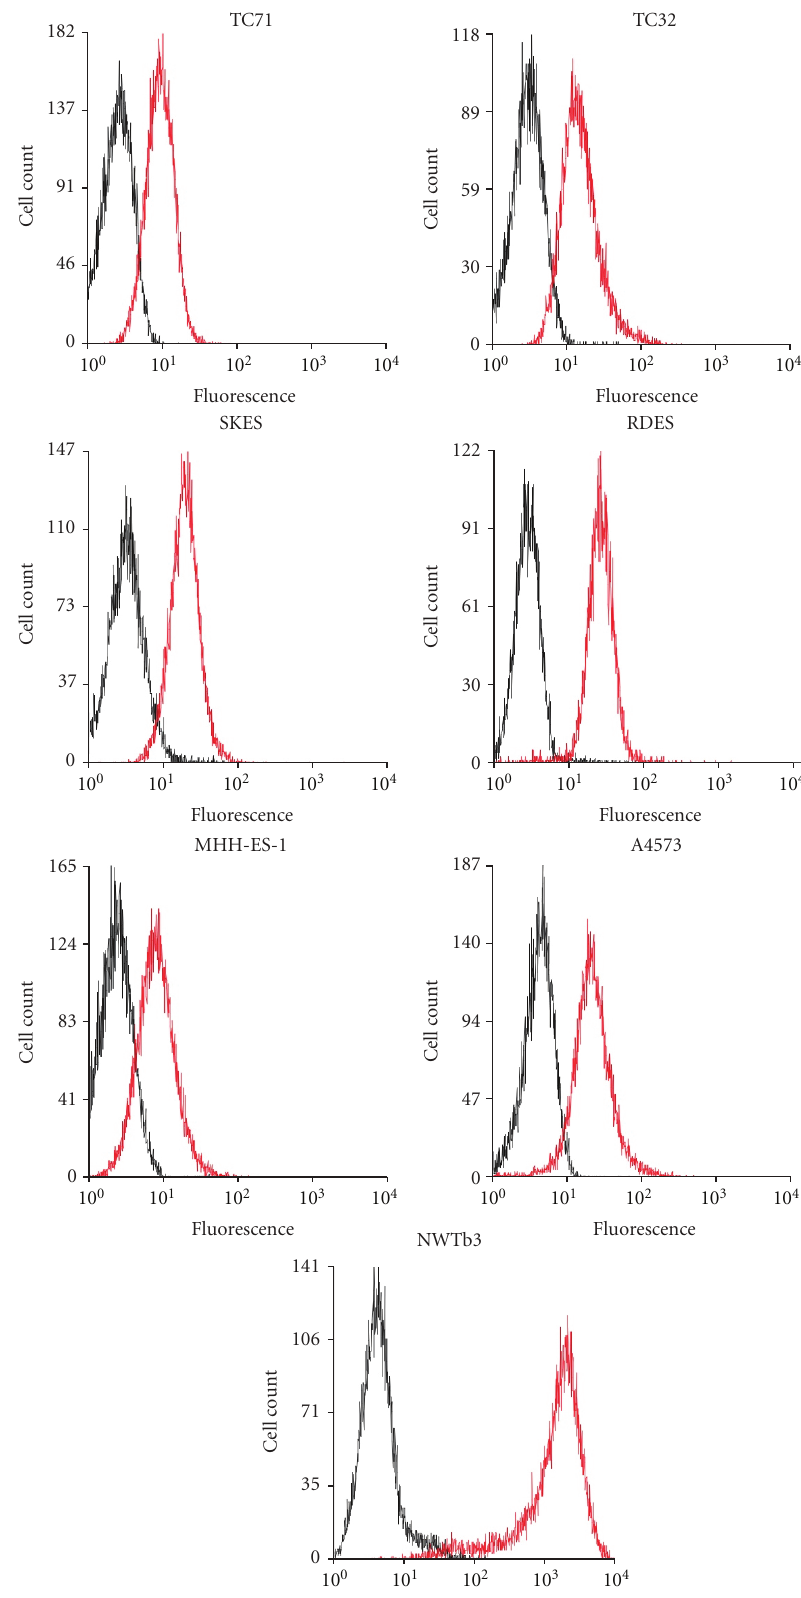
F 2: Flow cytometric analysis of IGF-1R-PE-labeled ES and NWTb3 cells. Black: unlabeled cells; Red: IGF-1R-PE-labeled